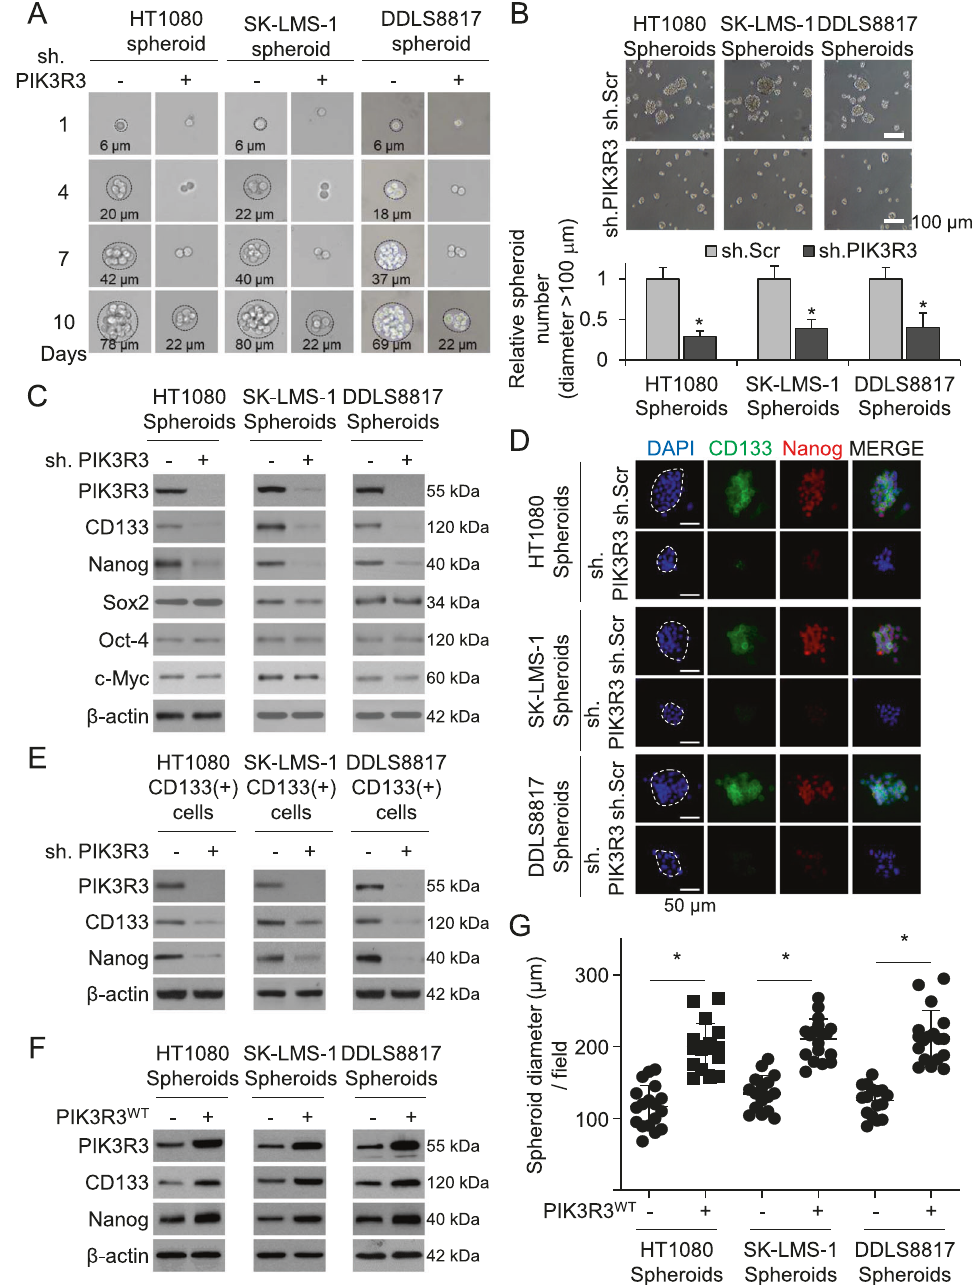
Fig. 2 Inhibition of PIK3R3 inhibits stemness of sarcoma CSCs. A – E Compare sh.PIK3R3- vs. sh.Scr-transduced sarcoma cells. All experiments except C were done in spheroid-cultured cells. Single-cell ( A ) and standard spheroid (>100 μ m) formation ( B ), with quantitation of spheroid diameter at 7 days post-transduction. C Western blot for PIK3R3, CD133, Nanog, Sox2, Oct-4, and c-Myc. D Immunostaining for CD133 and Nanog (with DAPI counterstaining). E Western blot for PIK3R3, CD133 an Nanog in sorted CD133 + cells. F – G Compare WT PIK3R3 vs. carrier- transduced cells. F Western blot for PIK3R3, CD133 and Nanog. G Spheroid diameter. β -actin is the loading control. * p < 0.05 compared to